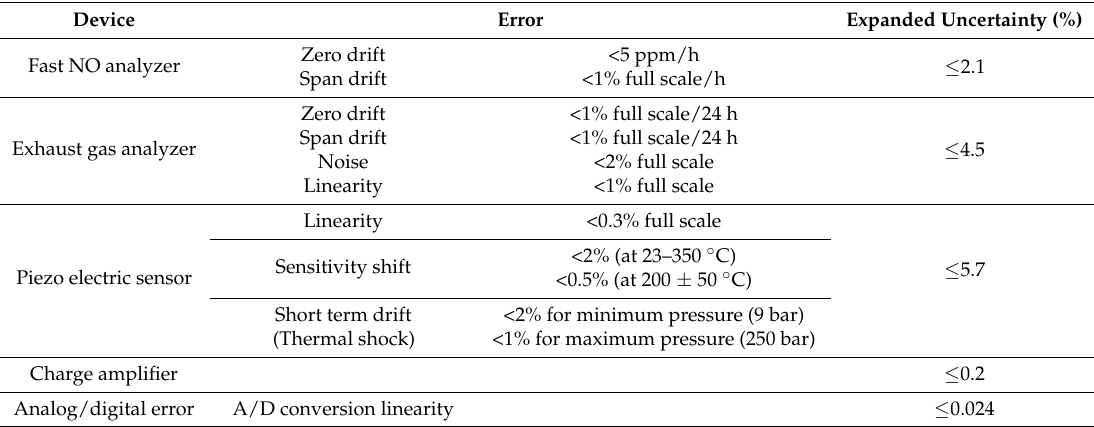
Table 2. Main sources of measurement errors and the expanded uncertainties.